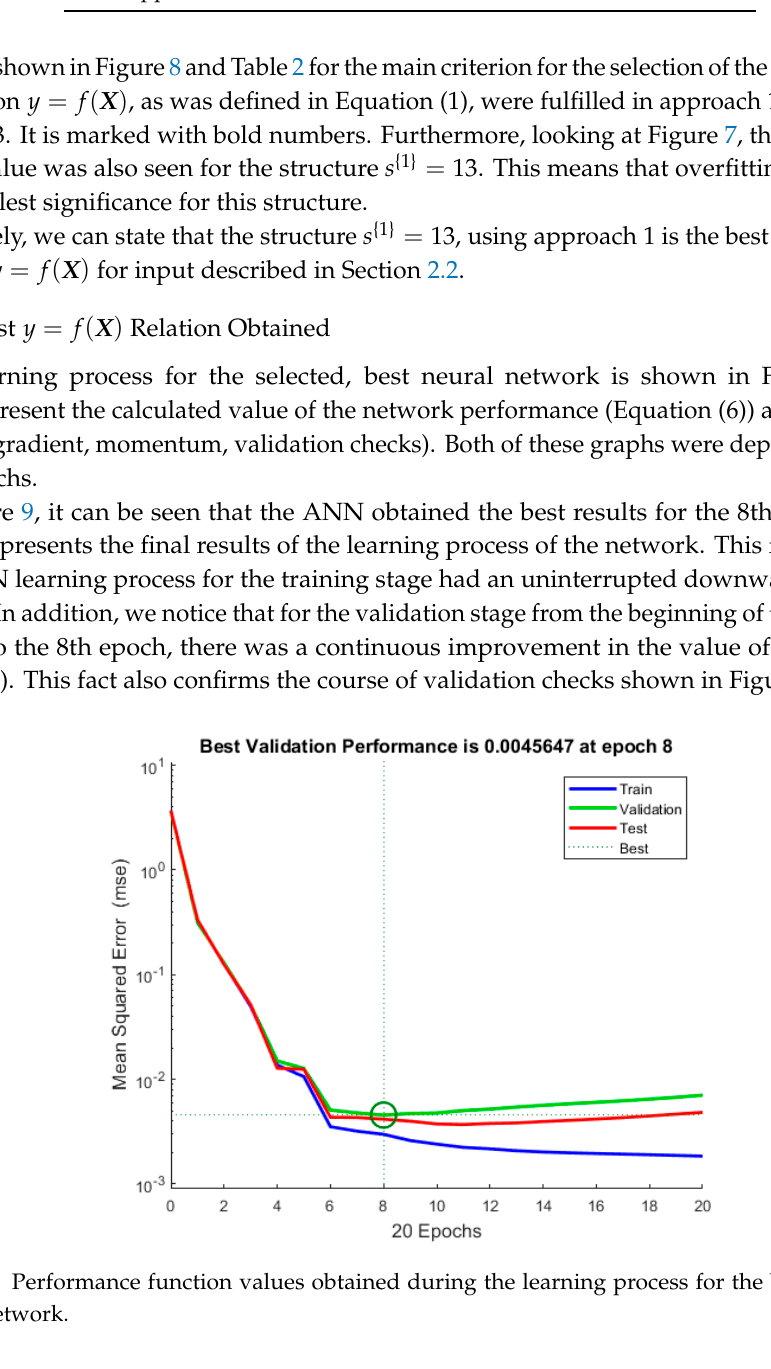
Table 2. Maximum absolute relative error obtained for the test stages for neural network structures with s { 1 } = 8, 13, and 14 neurons.